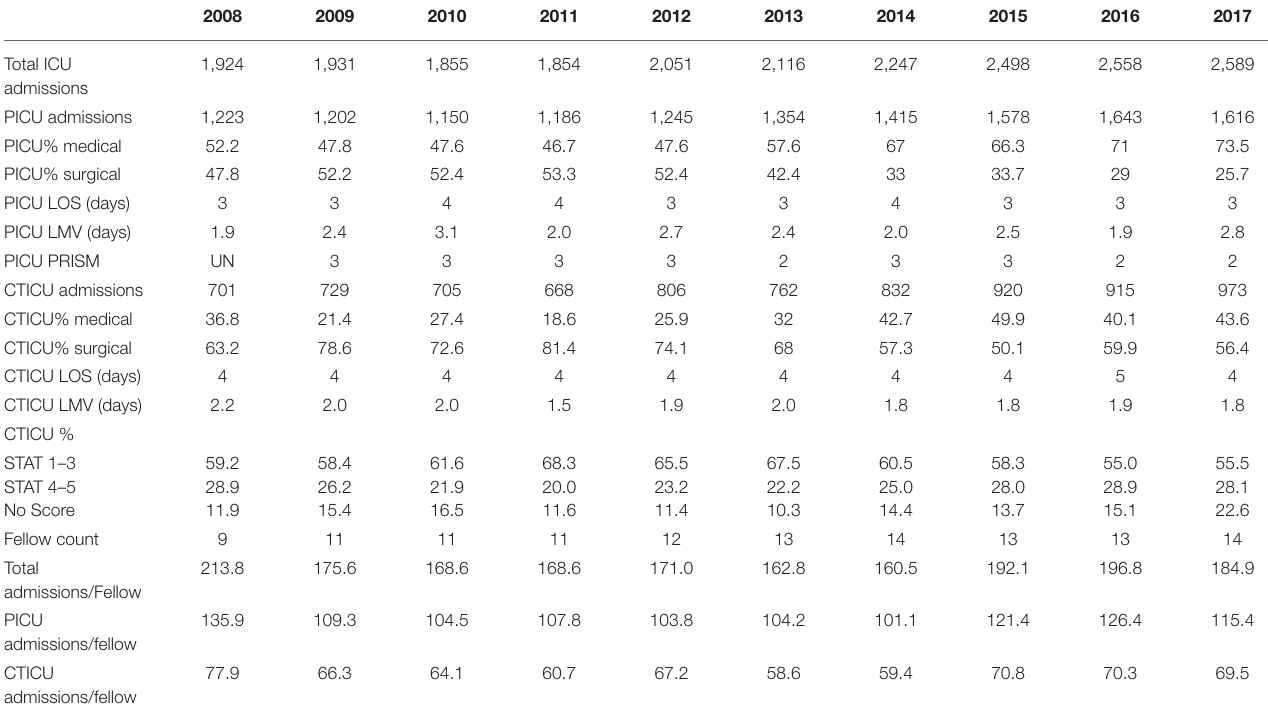
TABLE 1 | Characteristics of the Pediatric Intensive Care Unit, Cardiothoracic Intensive Care Unit, and Critical Care Medicine Fellowship Program.